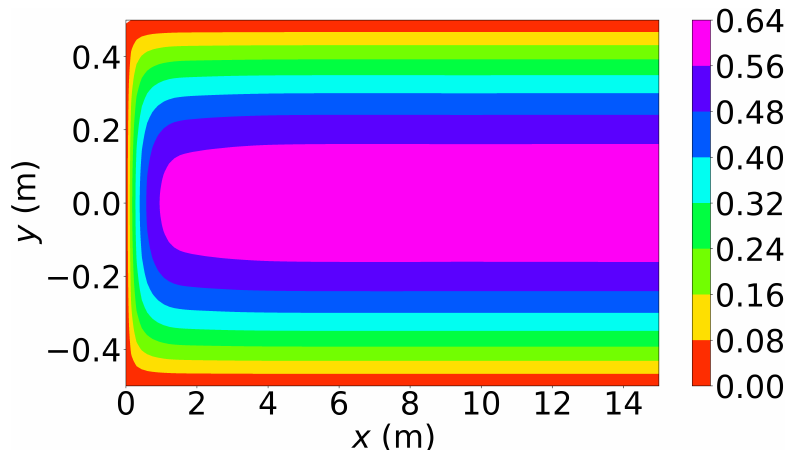
Figure 8. u -velocity in meters per second at 3.0